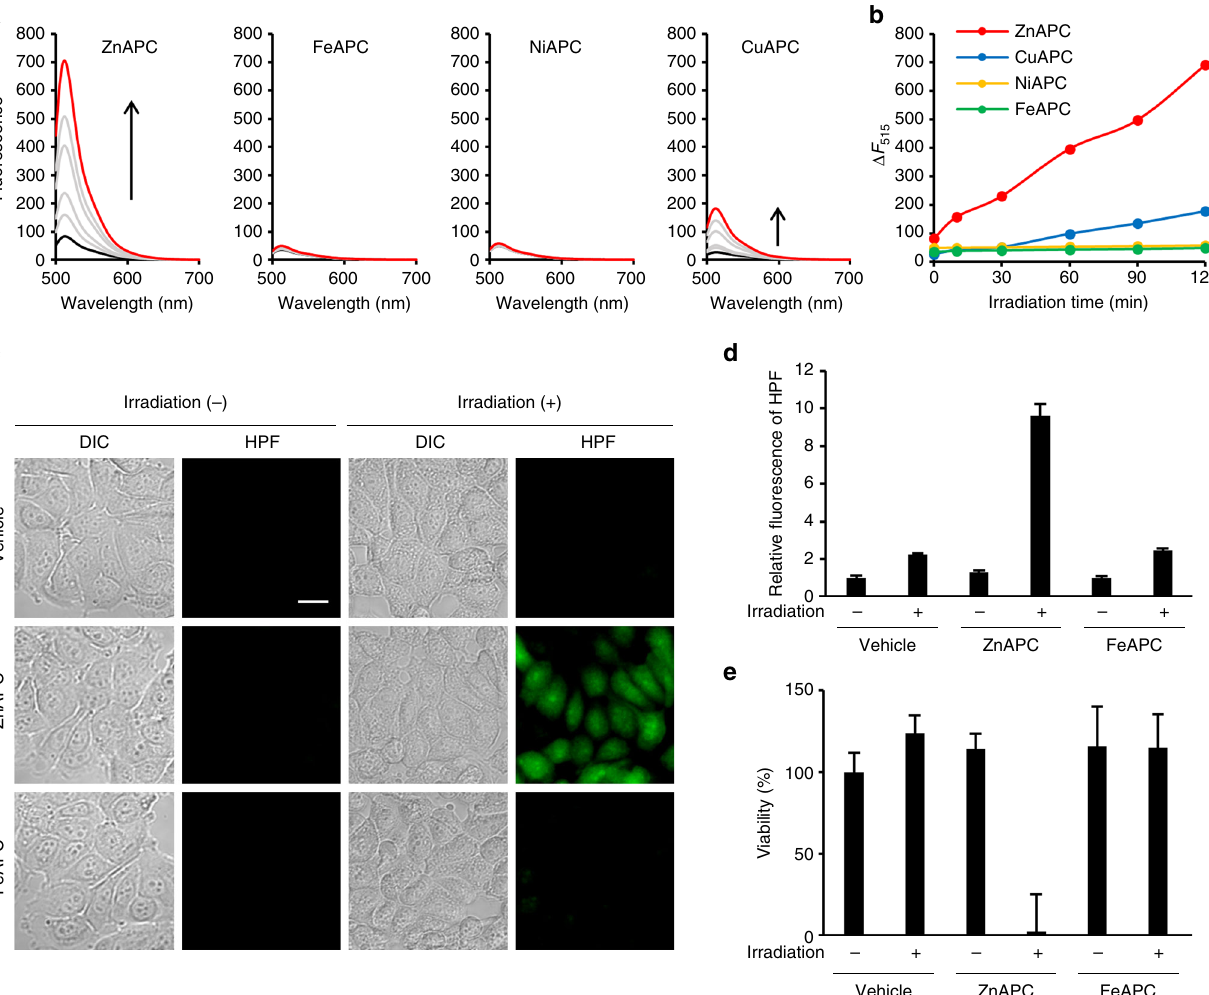
Fig. 2 ZnAPC induces ROS production in vitro and in cells. a Fluorescence spectra of 10 μ M HPF as an ROS indicator in the presence of 2 μ M ZnAPC, FeAPC, NiAPC or CuAPC at 25 °C. Excitation wavelength was 490 nm. The spectra at irradiation time points 0 and 120 min are highlighted in black and red, respectively. b Plots of the change in fl uorescence intensity of HPF at 515 nm during the photo-irradiation. c Evaluation of ROS levels by means of HPF in MCF-7 cells treated with ZnAPC or FeAPC after photo-irradiation for 1 h. DIC images of cells and fl uorescent images of HPF are presented. Scale bar, 20 µ m. d The mean fl uorescence intensity of HPF was quanti fi ed. Relative fl uorescence intensities are shown, and each bar represents mean ± SD for 10 images. e Cells pre-treated with ZnAPC or FeAPC for 1 h were incubated for 24 h after photo-irradiation for 2 h. The number of viable cells was determined by Trypan Blue exclusion – based cell staining. The number of treated cells was normalised to that of untreated cells. Each bar represents mean ± SD; n =